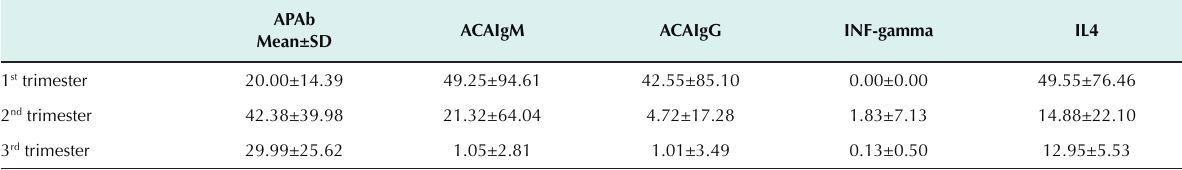
Table 7. APA Ab, ACA IgM, ACA IgG, INF-gamma, and IL-4 in the 1 st , 2 nd , and 3 rd Trimester in a Normal